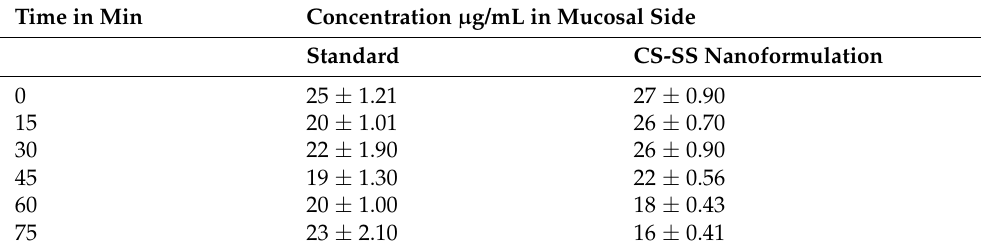
Table 1. The concentration of simvastatin in the mucosal side of everted intestine for the pure sample and CS-SS nanoformulation.